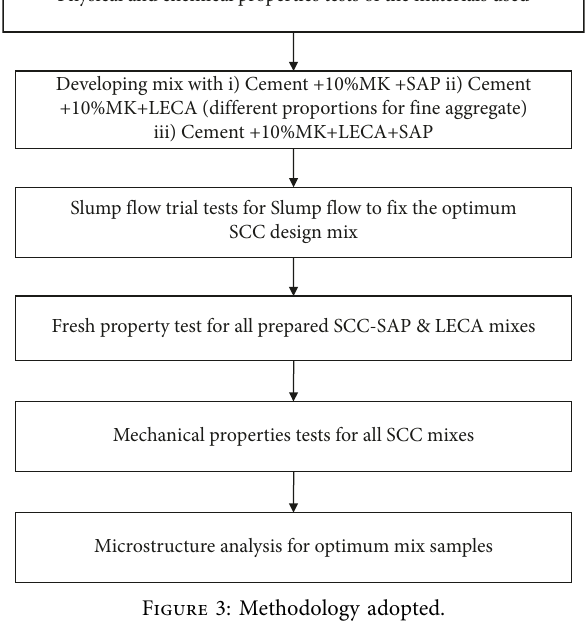
Figure 3: Methodology